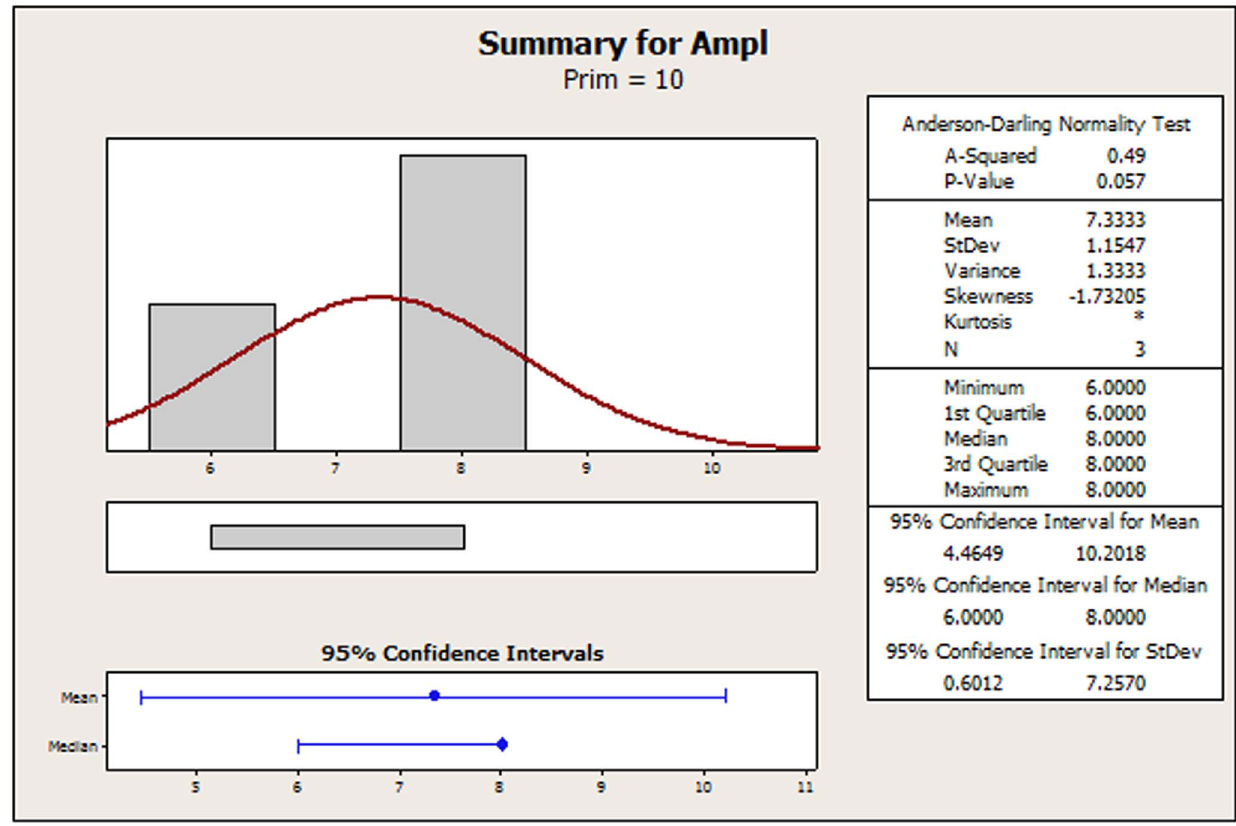
Figure 4. Summary statistics of amplicon performance for primer concentration at 10 pM/ m L. doi:10.1371/journal.pone.0108973.g004 Table 3 that the concentrations of the DNA template and dNTP should drop out as statistically dormant influences (p . 0.1). It is